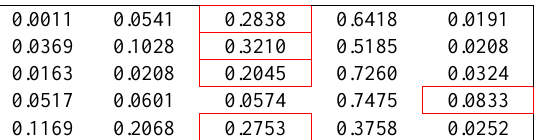
Figure 5. Second output of each rule.